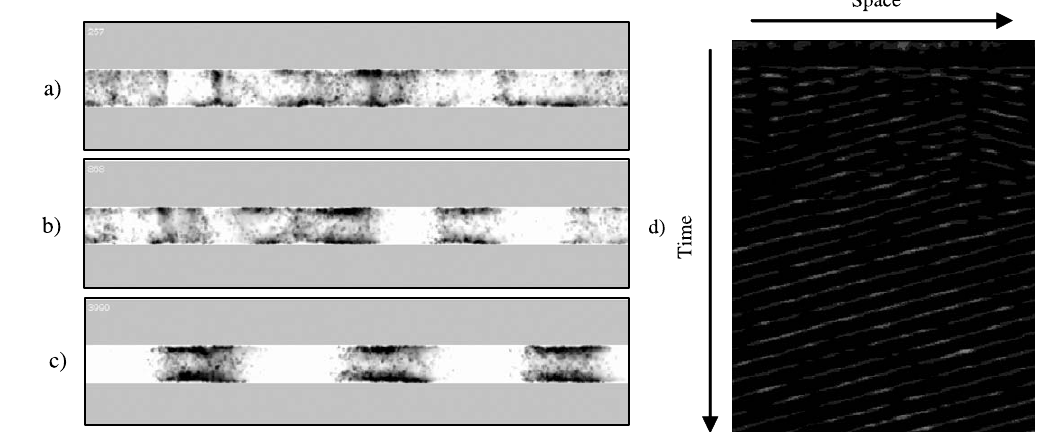
Fig. 11. Emergence of travelling wave transport in a tube shaped environment Left: Snapshots taken at a) 257, b) 868 and c) 3990 scheduler steps Right: Space time plot showing emergence of regular transport.